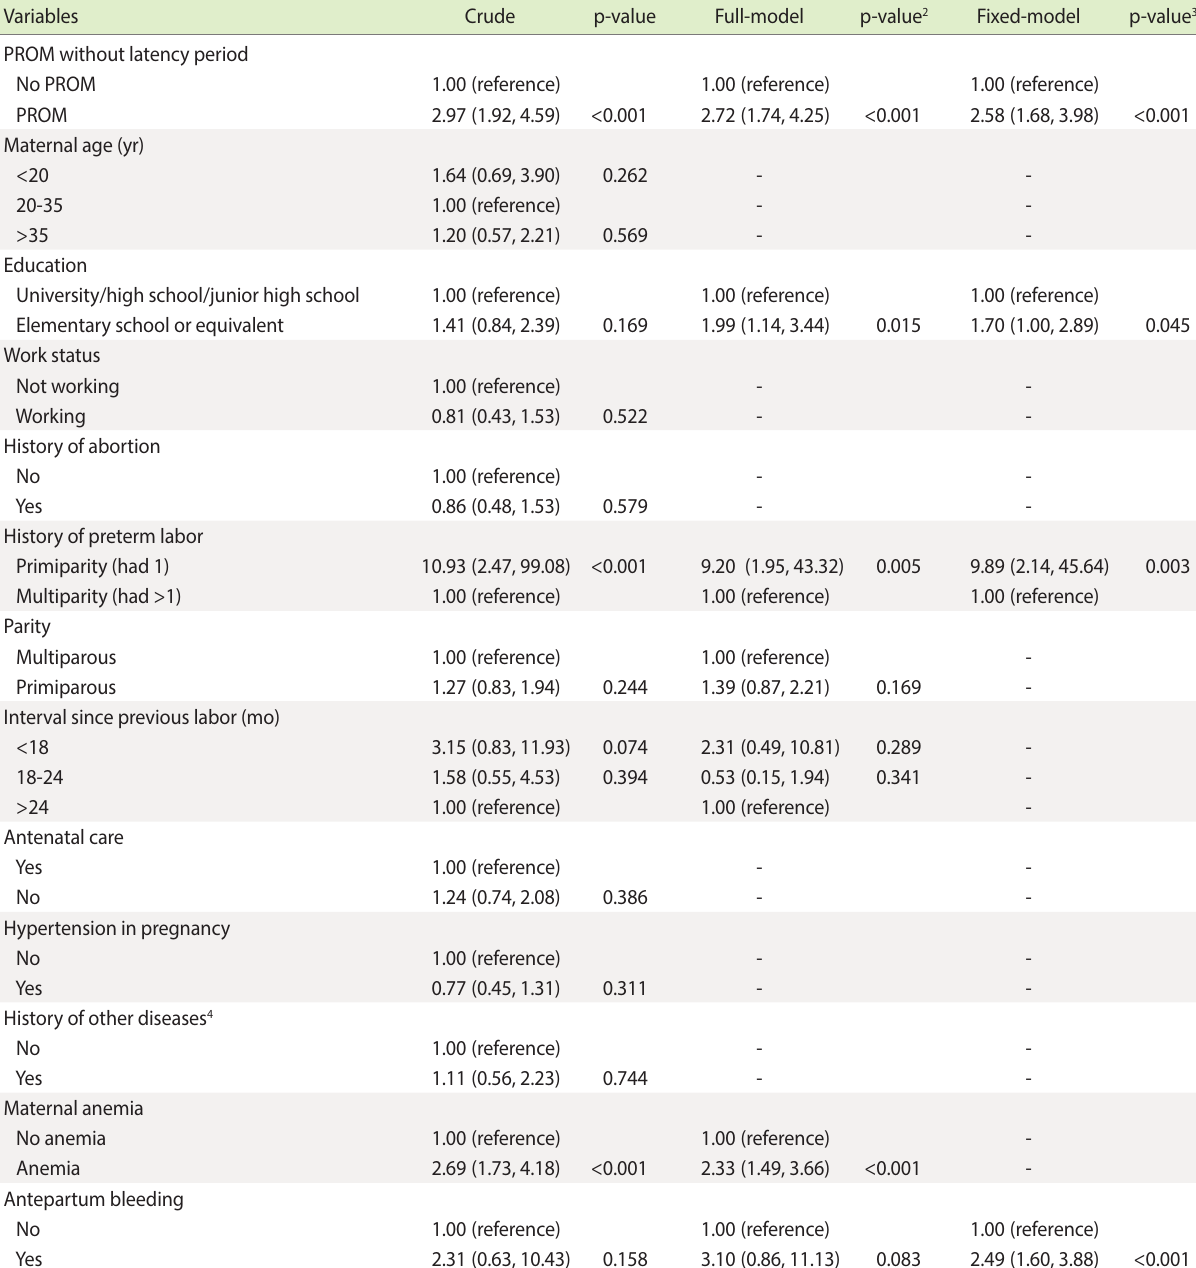
Table 2. Association of premature rupture of membranes (PROM), maternal characteristics, obstetric history, and current condition of preg- nancy with preterm labor